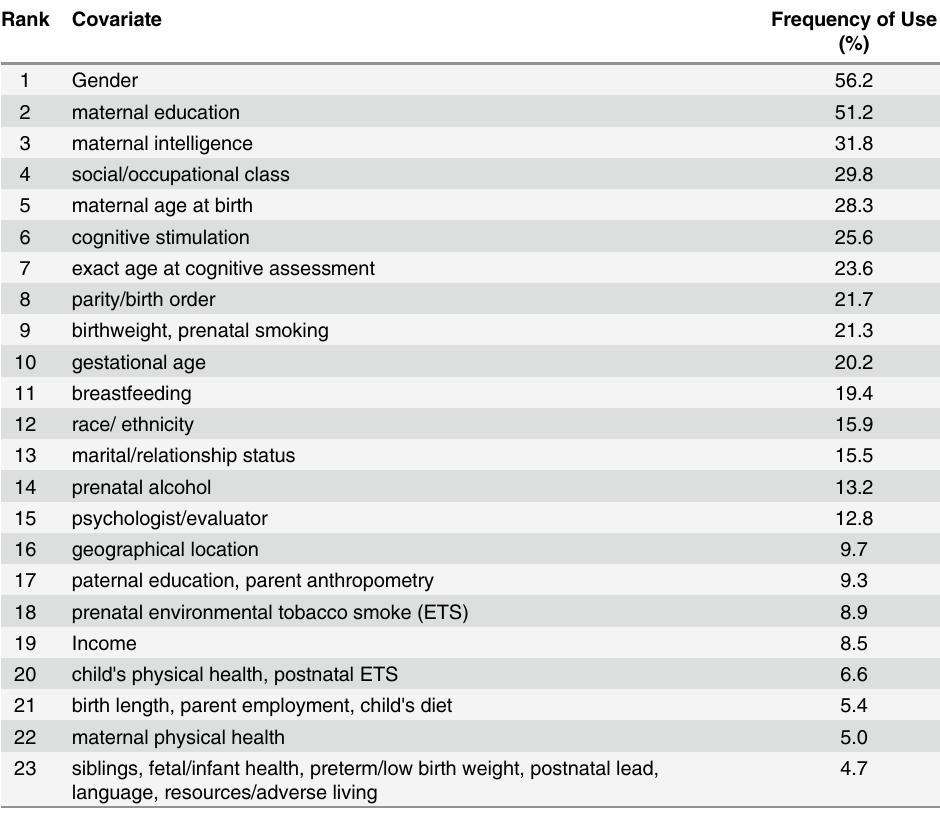
Table 3. Covariates Used Across Publications Included in the